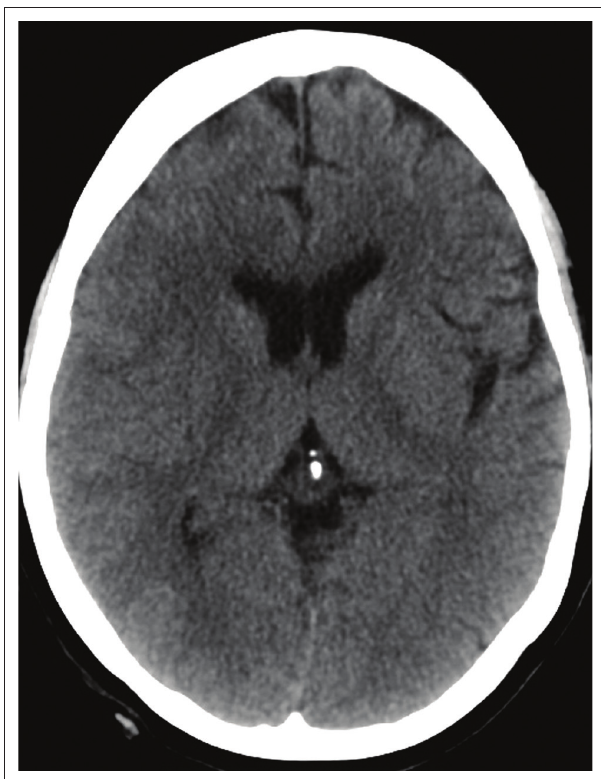
FIGURE 4: Axial noncontrasted CT image.